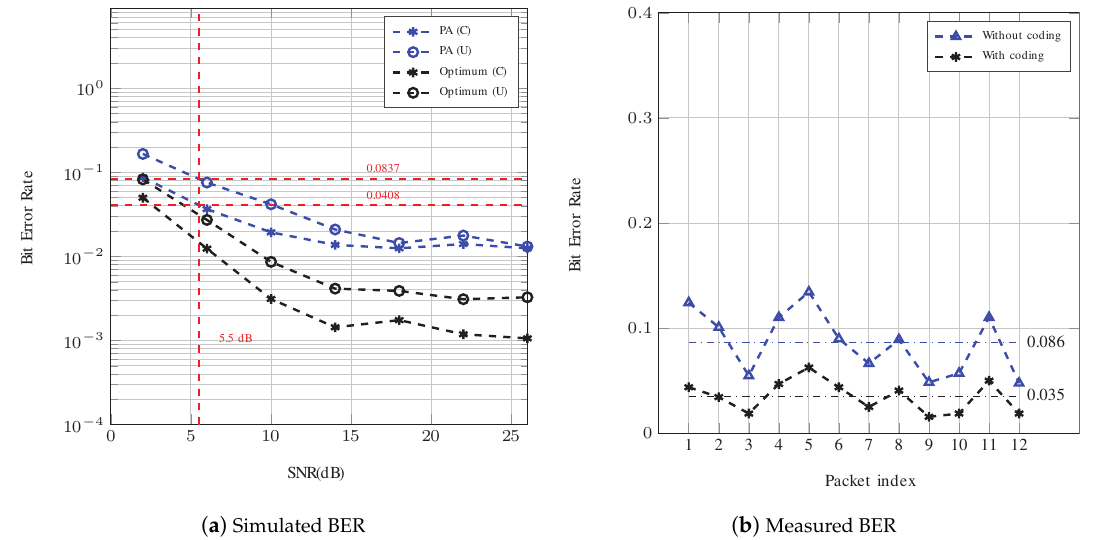
Figure 10. BER analysis of Config. #2. The red dotted lines in ( a ) show the value of BER at 5.5 dB for system with PA compensation (with and without coding). The horizontal lines in ( b ) are used to identify the average measured